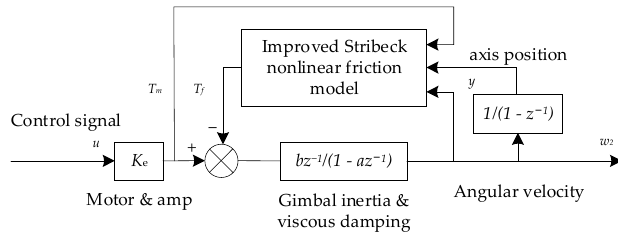
Figure 8. Open-loop nonlinear system model of velocity [60].